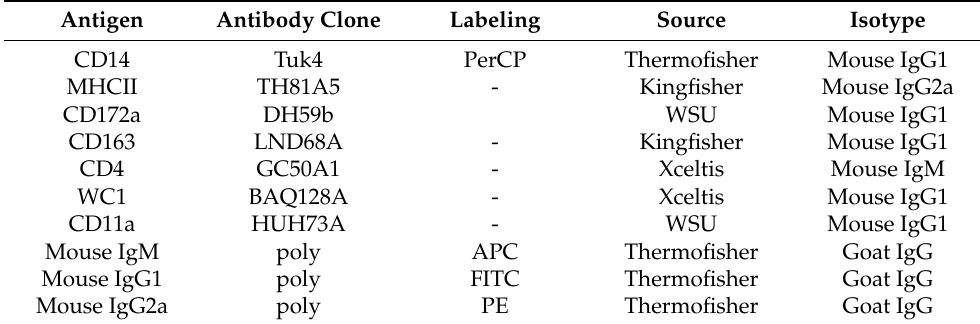
Table 1. List of